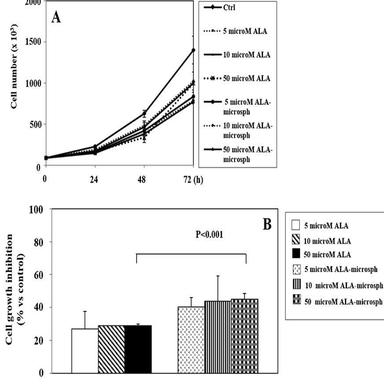
(A) Effect of ALA, in its free form, or delivered by hydrogel at increasing concentrations (5–50 μM) on the growth of HCT116 human colon adenocarcinoma cells evaluated at different time points (24–72 h). (B) Effect of a 72 h treatment with 50 μM ALA, in its free form or delivered by hydrogel, on the growth of HCT116 cells. (C) Effect of DHA, in its free form, or delivered by hydrogel at increasing concentrations (5–50 μM) on the growth of HCT116 human colon adenocarcinoma cells evaluated at different time p